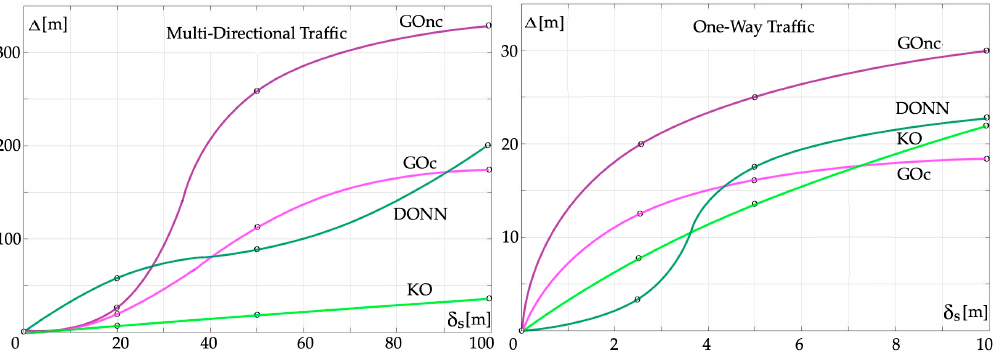
Figure 18. Values of the final deviation of the determined trajectories from their initial values for autonomous vehicles in multidirectional and one-way traffic depending on the safe passing distance for the KO, DONN, and GO algorithms.